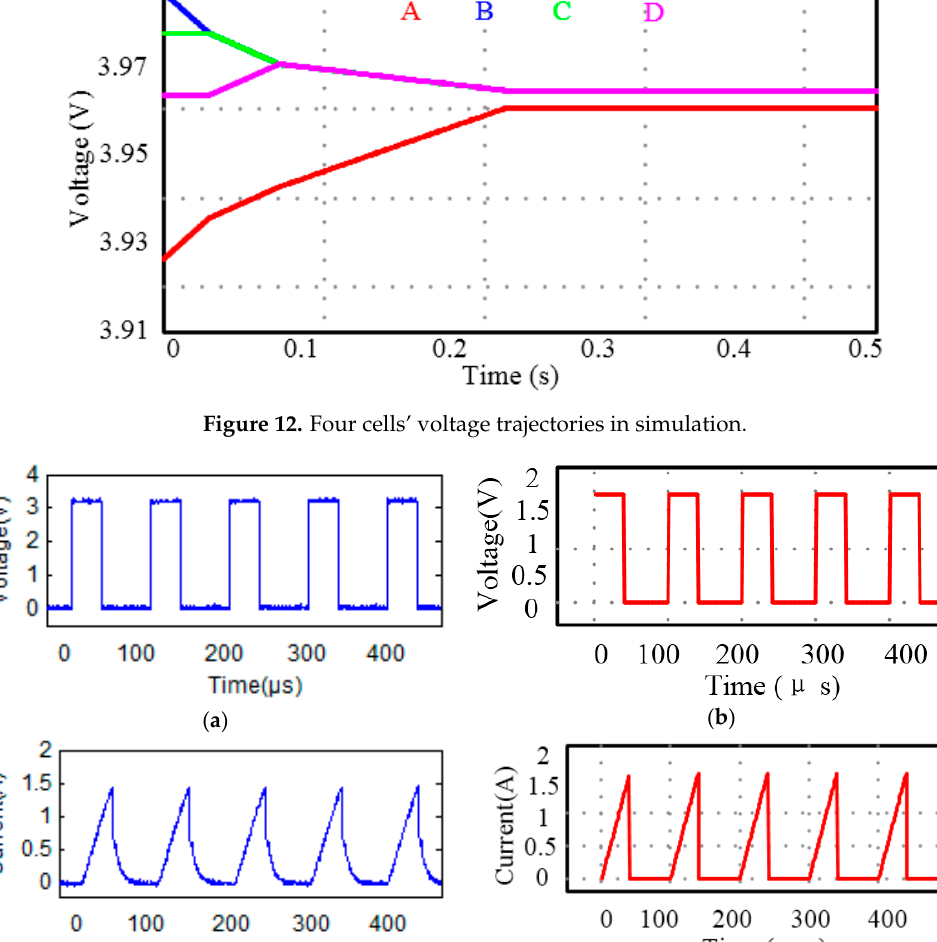
( d ) Figure 10. The cells’ voltage waveforms in the equalization process for A, B, C and D ( a ) A. ( b ) B. ( c ) C. ( d ) D. Figure 11. Voltages of the four cells before and after equalization. As shown in Figure 12, the initial voltage gap (59.5 mV) decreases to 4 mV at about 0.2139 s in the simulation. In the experiment, the batteries have internal resistance, the inductors have resistance and magnetic leakage, the MOSFETs have on-resistance, the voltage detection of the battery has errors, etc. As a result, the average voltage in the experiment is lower than the simulation result.